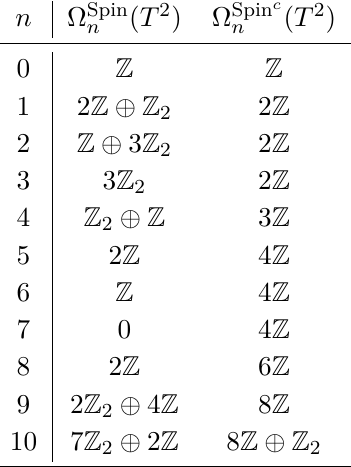
Table 24 . Cobordism groups of 2-torus, Ω Spin